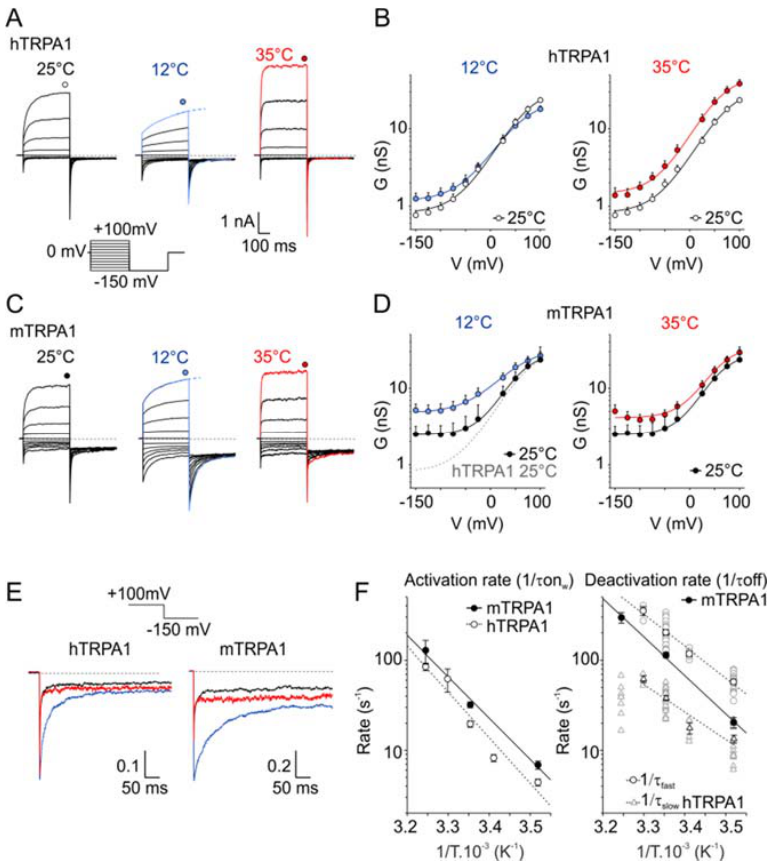
Figure 1. E ff ects of cooling and warming on the voltage-dependent gating kinetics of the human and mouse transient receptor potential (TRP) channel subtype A1 (TRPA1) orthologues. ( A ) Representative whole-cell currents in Ca 2 + -free intracellular and extracellular solutions recorded from a human embryonic kidney (HEK) 293T cell line transiently expressing the wild-type human TRPA1 (hTRPA1) channel, measured by the indicated voltage-step protocol at di ff erent temperatures. The voltage-step protocol was previously used by [17]. Steady-state currents were measured at the end of the pulses, as indicated by colored symbols atop each record. At 12 ◦ C, the steady-state currents were estimated from the exponential fit of the recorded activation curves, as indicated by dashed lines. ( B ) The average conductance of hTRPA1 was obtained from the voltage step protocols, as in ( A ). The data represent the means + SEM. ( n ≥ 6). The solid lines represent the best fit to a Boltzmann function, as described in Materials and Methods. ( C ) Representative whole-cell currents through wild-type mouse TRPA1 (mTRPA1), as in ( A ). ( D ) Average conductance of mTRPA1 obtained from voltage step protocols, as in ( C ). The data represent the means + SEM. ( n ≥ 4). The solid lines represent the best fit to a Boltzmann function, as described in Materials and methods. The fit of hTRPA1 at 25 ◦ C is overlaid as a grey dashed line for comparison. Note the increased basal conductance of mTRPA1 at negative potentials. ( E ) Comparison of the deactivation kinetics of TRPA1 orthologues at di ff erent temperatures. Representative tail currents normalized to the maximum amplitude at + 100 mV obtained as an indicated part of the voltage step protocols, as in ( A , C ). Color-coded as the rest of the figure: black for 25 ◦ C, red for 35 ◦ C, and blue 12 ◦ C. While the mTRPA1 tail currents could be fitted by a monoexponential function, the hTRPA1 tail currents could be well-fitted only by two exponentials. ( F ) Arrhenius plots of the onset (left) and deactivation (right) time constants for hTRPA1 (open symbols) and mTRPA1 (close symbols). The time constants of the onset were determined by mono- (mTRPA1) or bi-exponential (hTRPA1, plotted as weighted mean) fits to the time course of the onset currents at + 100 mV, as in ( A , C ). The time constants of the deactivation rate were determined by mono- (mTRPA1) or bi-exponential (hTRPA1, fast and slow components plotted separately as open circles and triangles) fits to the tail currents, as in ( E